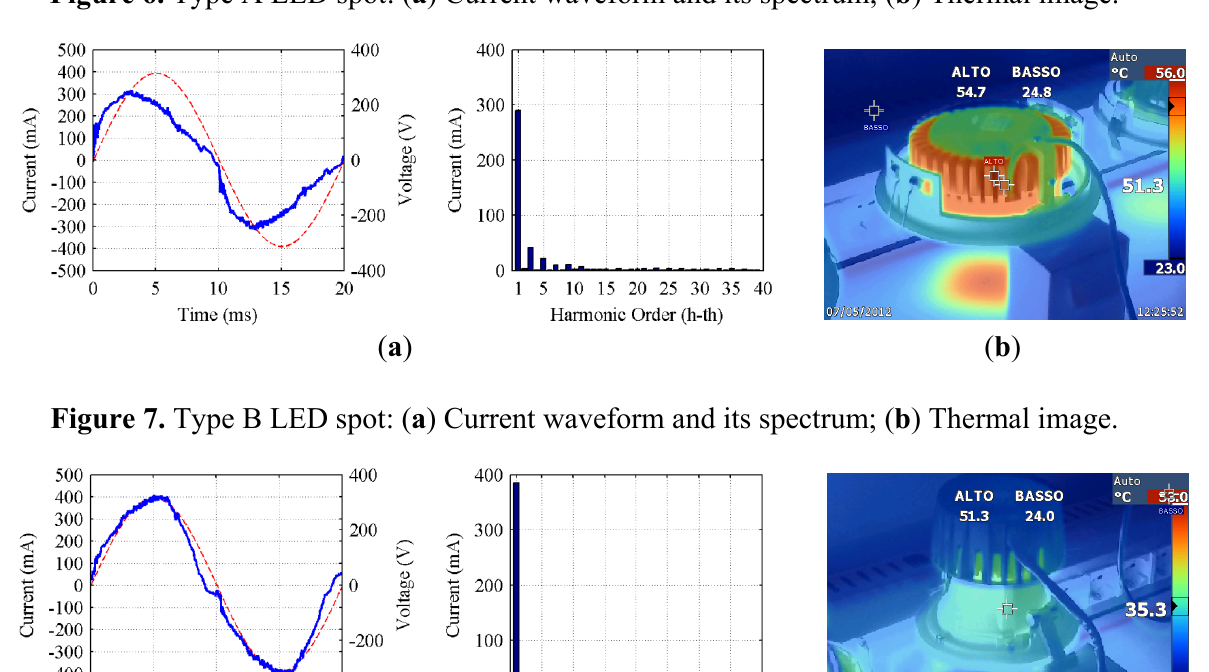
Figure 6. Type A LED spot: ( a ) Current waveform and its spectrum; ( b ) Thermal image.